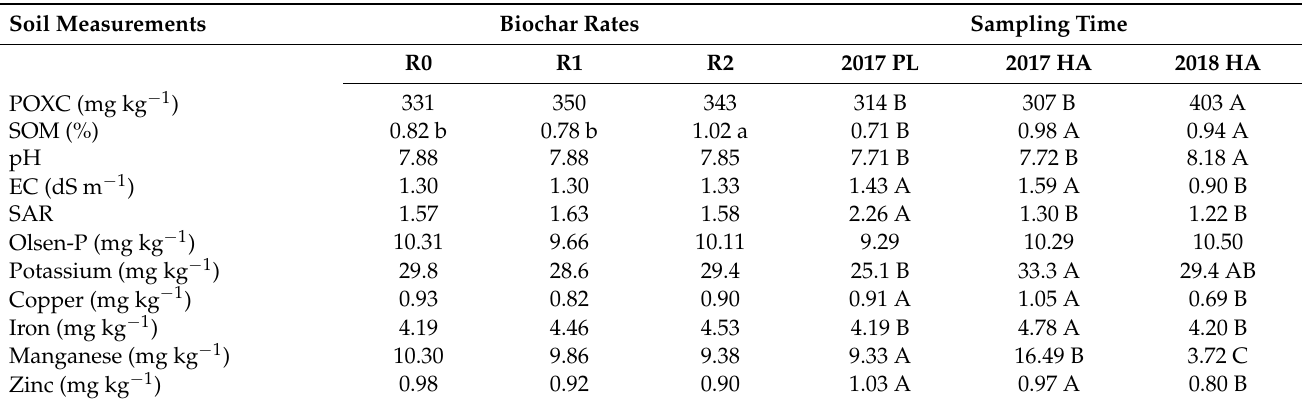
Table 6. Sorghum–Sudan treatment means for soil properties averaged across biochar treatments and sampling times: PL-before planting, HA-after harvest.